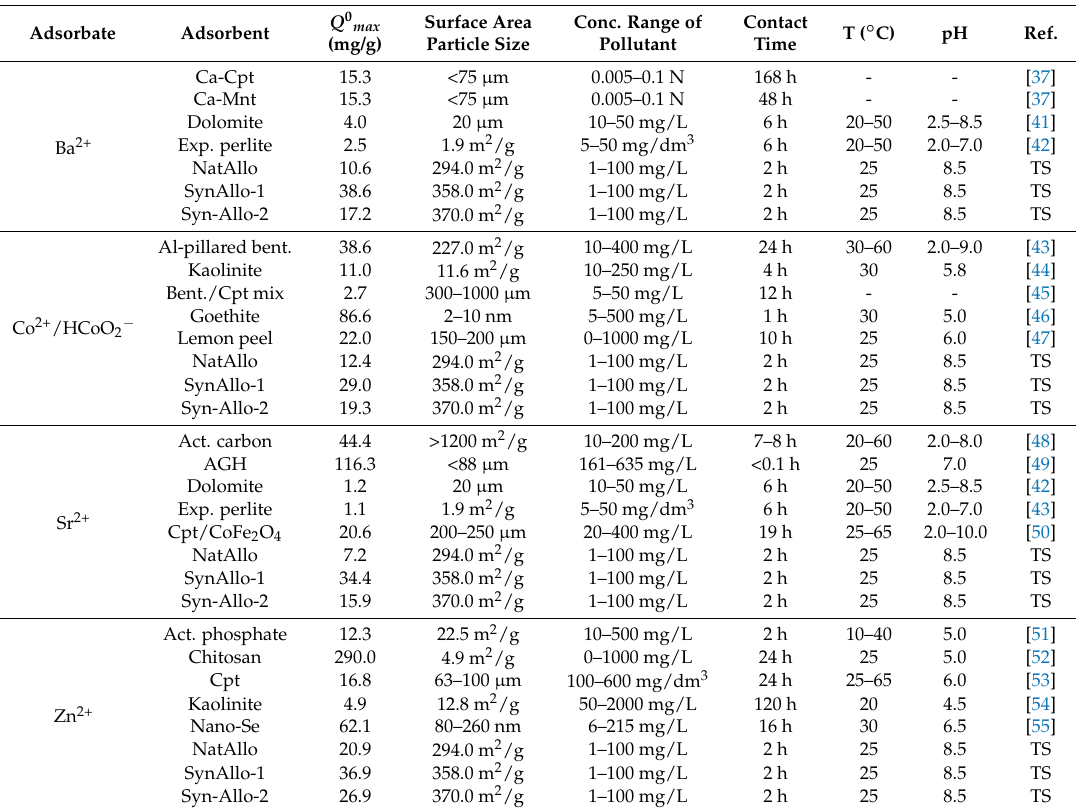
Table 4. Comparison of the adsorption potential of natural and synthetic allophanes with other commercially available adsorbents used for the removal of aqueous Ba, Co, Sr, and Zn. Cpt = clinoptilolite; AGH = almond green hull; Mnt = montmorillonite; Bent = bentonite; TS = this